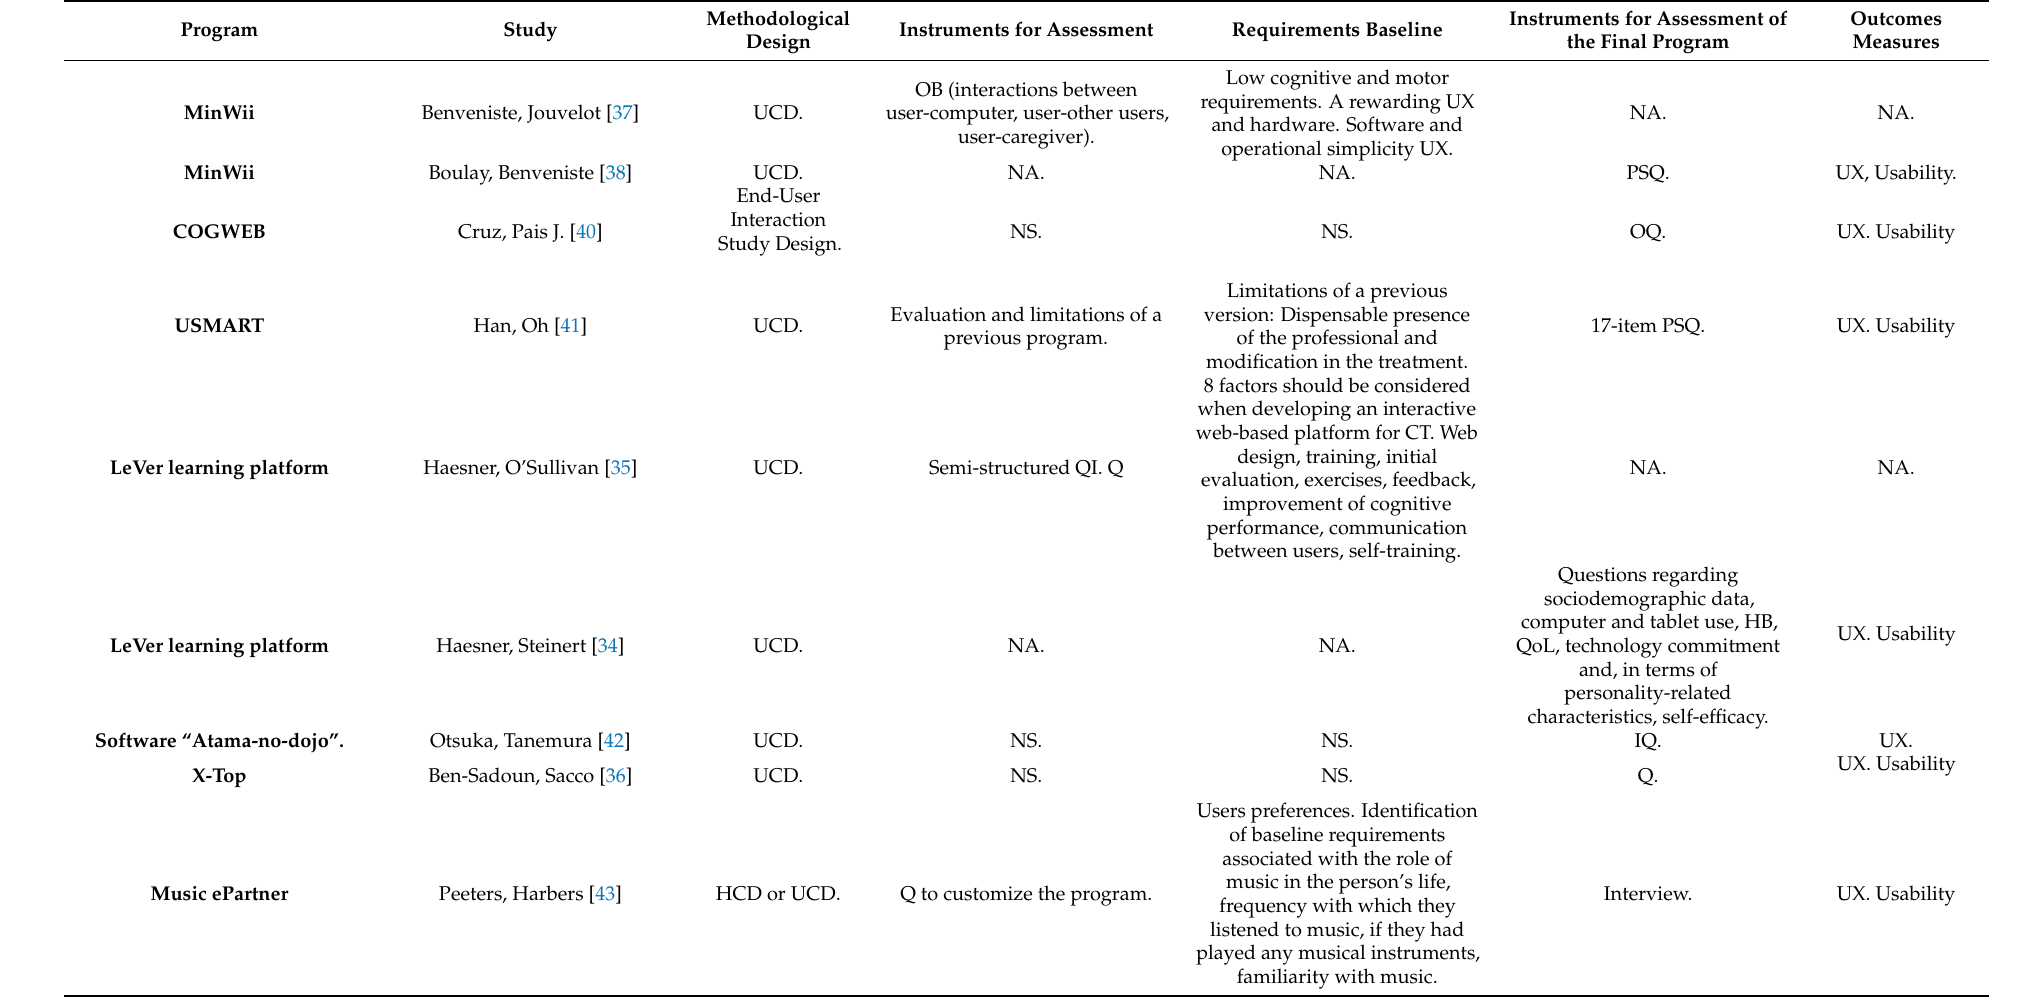
Table 3. User requirements baseline and main outcome